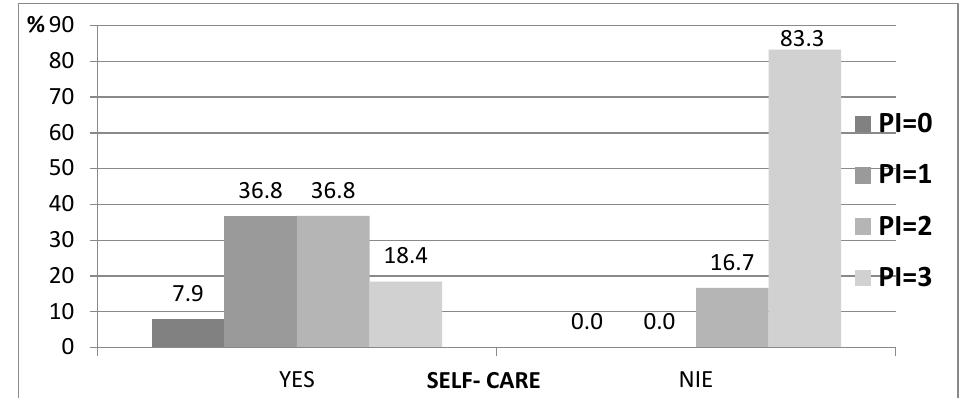
Figure 4. Relationship between PI and self-care. Regarding to the gingival index, among residents performing hygienic activities on their own, 26.3% had GI = 2 and 2.6% subjects had GI = 3. In the group of residents whose oral hygiene was dependent on carers, as many as 66.7% had GI = 2 and 33.3% GI = 3 ( p = 0.003) (Table 6, Figure 5). Table 6. Results of the questionnaire in relation to the GI.